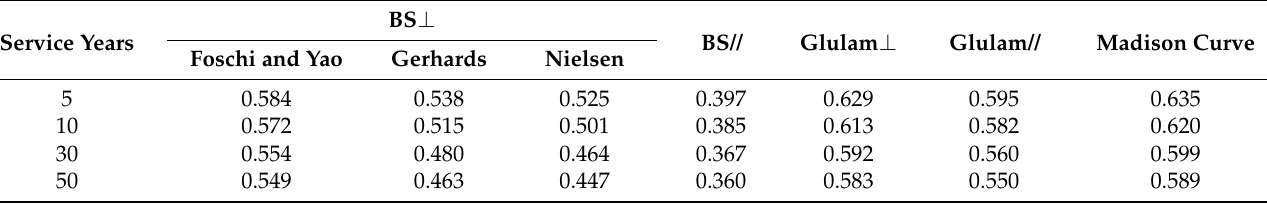
Table 3. DOL factors for different materials.